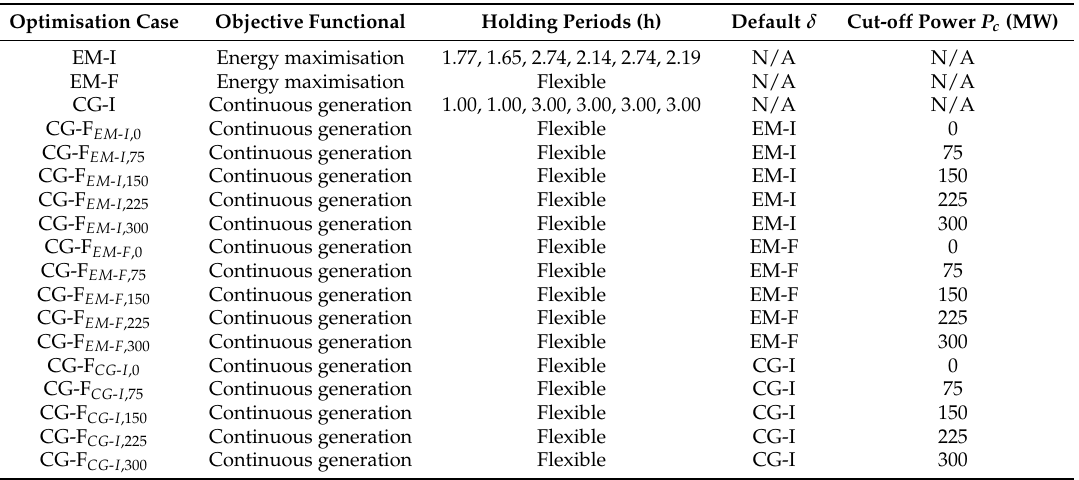
Table 2. Summary of optimisation cases applied in this study. Unless classed as “Flexible”, inflexible holding periods are presented in the following order: CBL t h , e , CBL t h , f , MB t h , e , MB t h , f , WSL t h , e , WSL t h , f